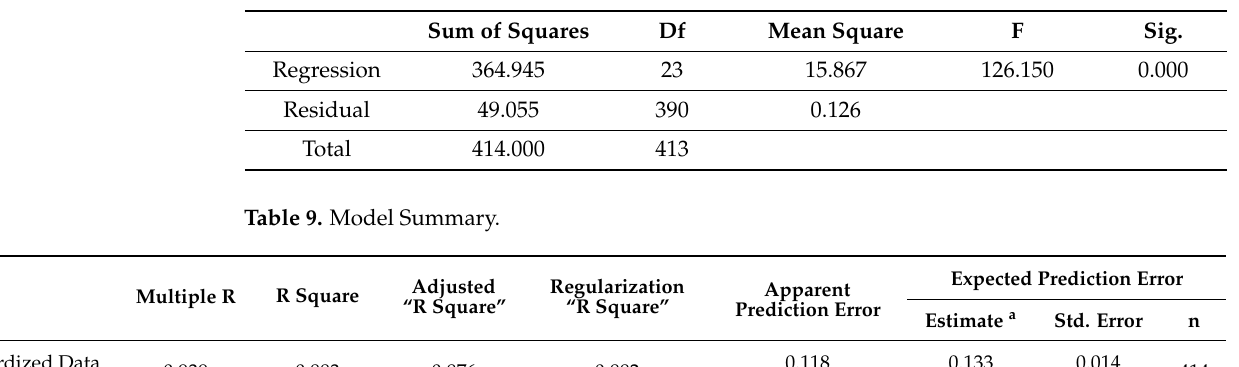
Table 8. ANOVA results.